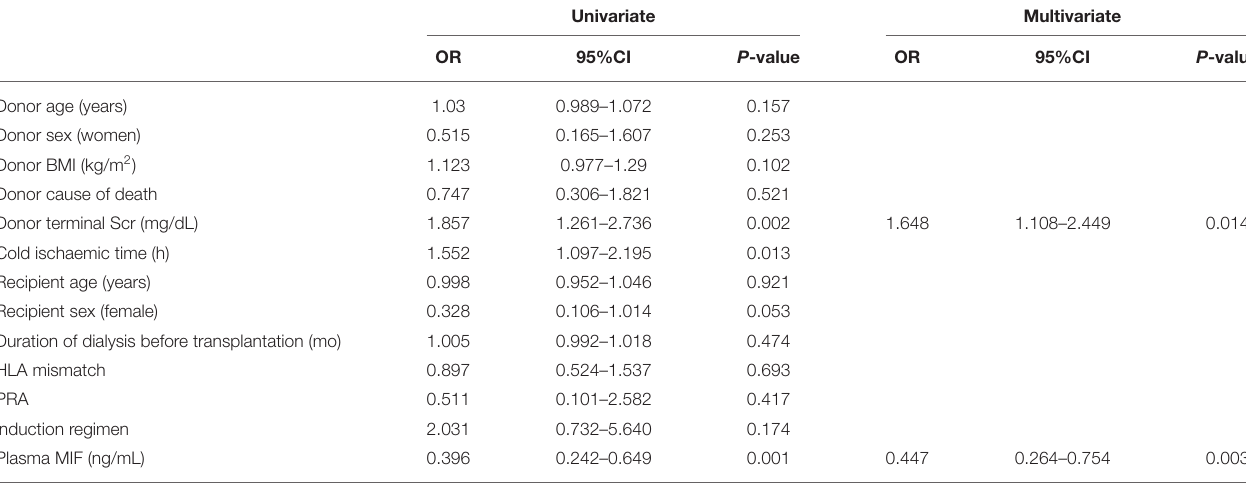
TABLE 2 | Univariate and multivariate logistic regression analyses for predicting delayed graft